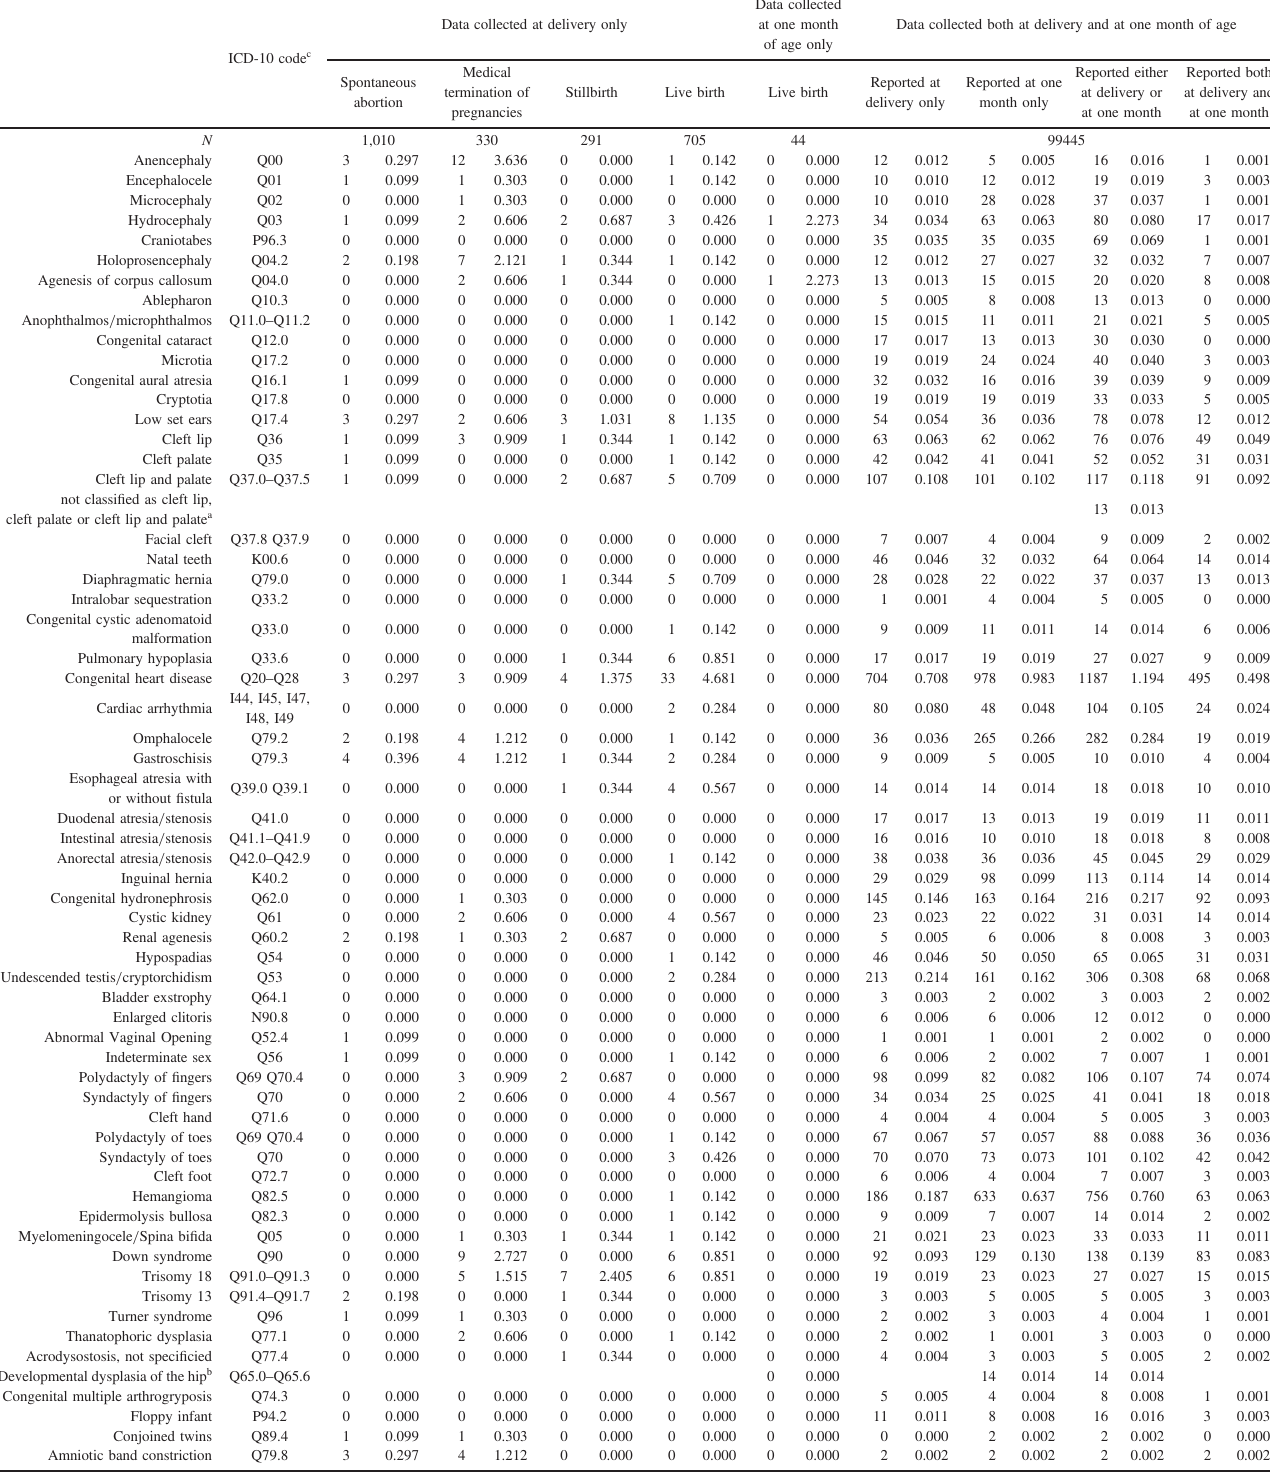
Table 1. Number and percentage of the 61 congenital anomalies of interest according to reporting and data collection patterns